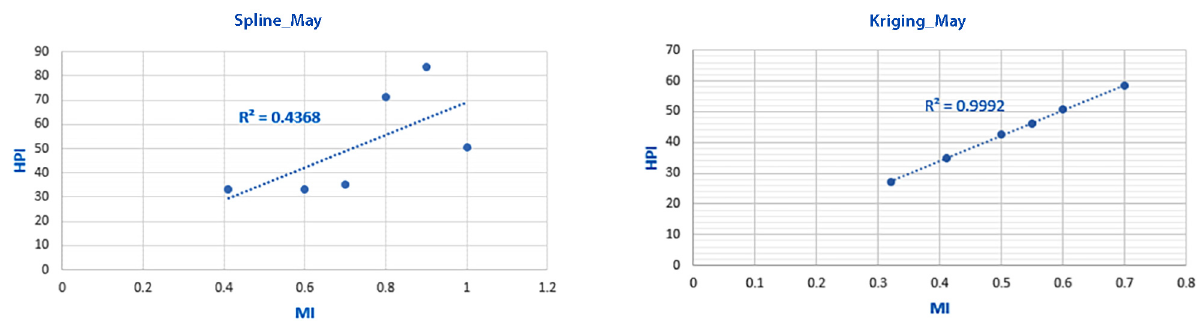
Figure 8. Correlation analysis of May, 2018 (Spline and Kriging)